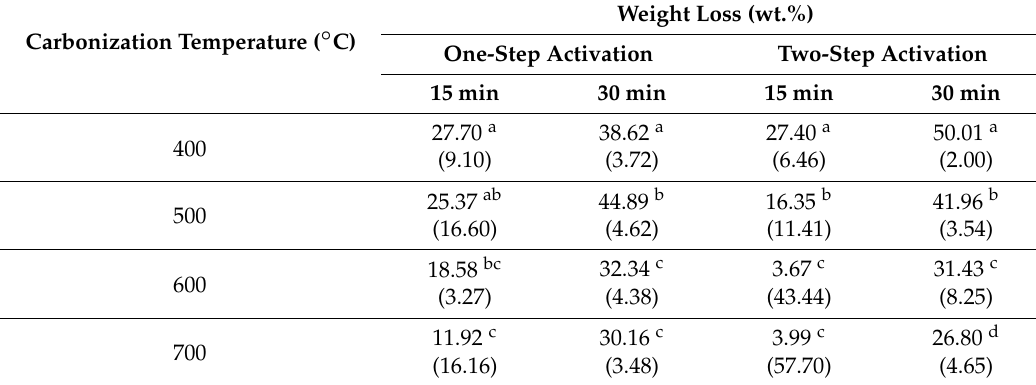
Table 1. Weight loss of produced